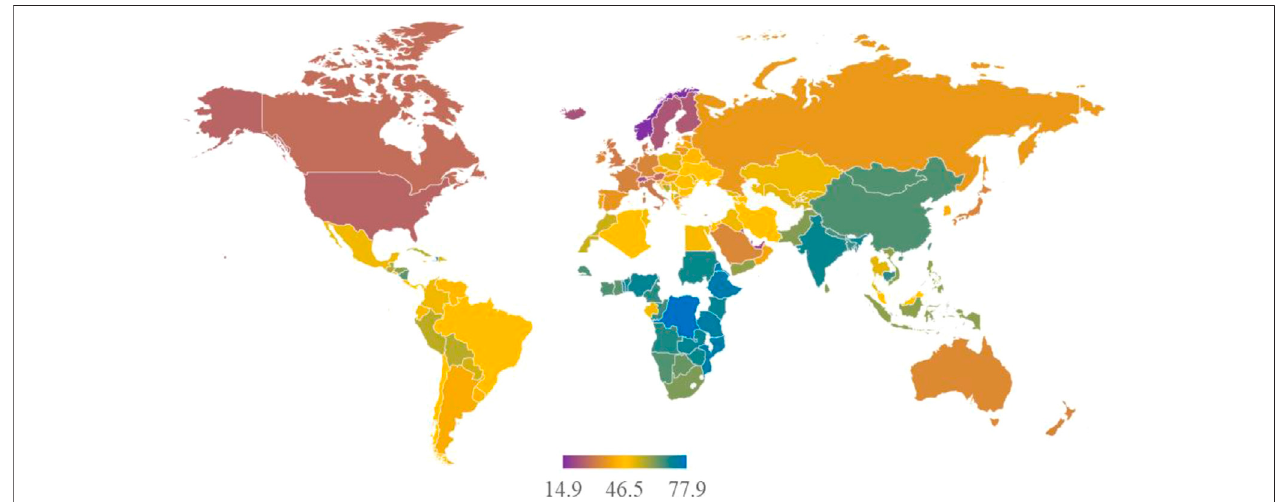
FIGURE 2 | Average MEAI between 2001 and 2016 for 125 global